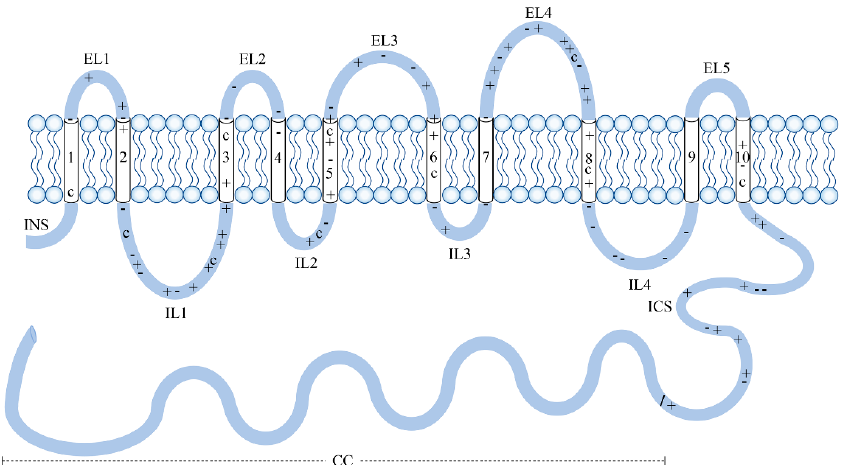
Figure 1. Silicic acid transporters (SITs) in Cylindrotheca fusiformis . SITs contain 10 transmembrane segments (white cylinders), which allow the passage of silicic acid through the lipid bilayer mem- brane; an intracellular amino-terminal segment (INS); and an intracellular carboxy segment (ICS) connected to a coiled-coil motif (CC), which may play a role in the interactions with other proteins. Pluses (+) and minuses ( - ) indicate the position of positively and negatively charged amino acids, respectively. A major role in silicon uptake is likely played by cysteine residues (C) because of their sulfhydryl blocking agents. Figure redrawn from [31].